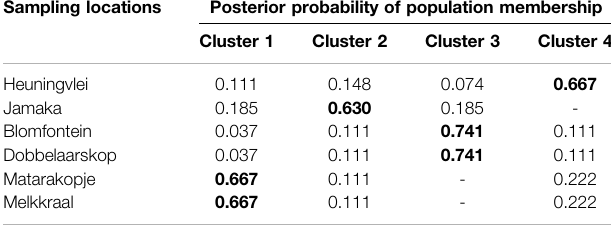
TABLE 9 | Assignment probabilities of individuals from the six geographical locations to the identi fi ed clusters. Sampling